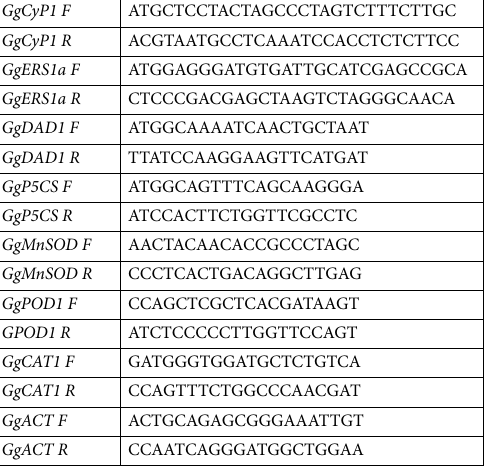
Table 1. Gene code numbers and primer sequences used for transcript quantification by